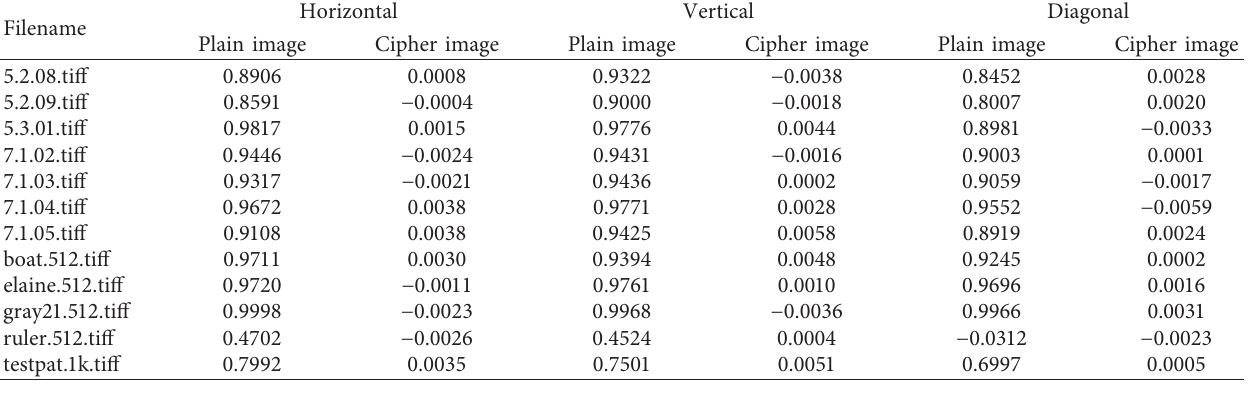
Table 11: Correlation test results for adjacent pixels of plain images and their cipher images.